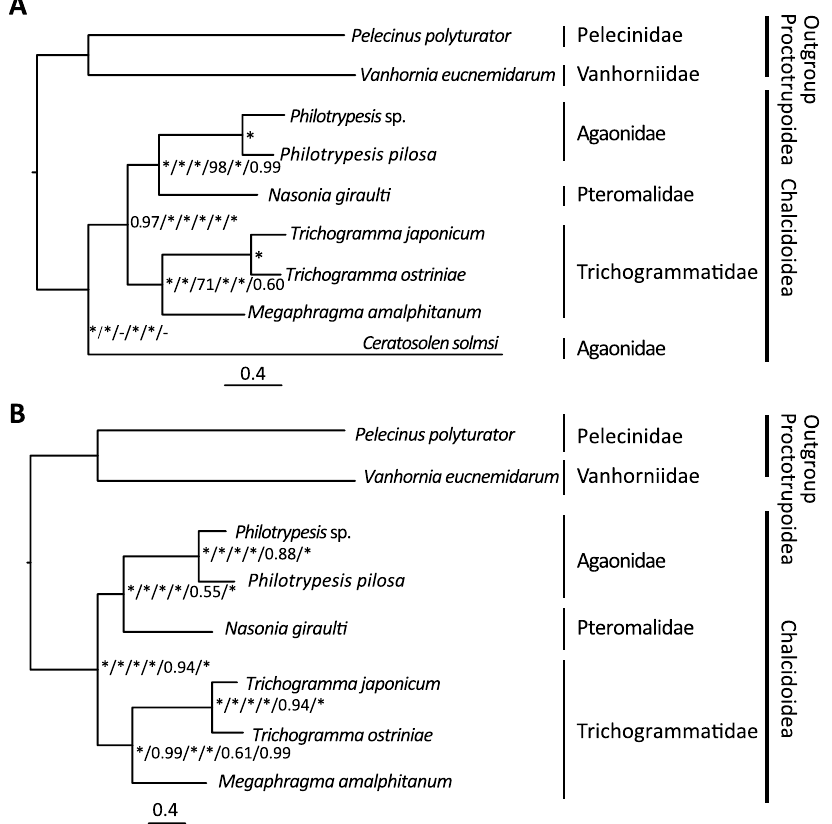
Figure 3. Phylogenetic relationships within Chalcidoidea based on the nucleotide and amino acids sequences of 13 protein-coding genes. ( A ) Seven species of Chalcidoidea with mitochondrial genome sequence were included. ( B ) Ceratosolen solmsi was excluded from analysis to avoid the potential long-branch attraction. The values separated by “/” near the nodes represent support rates of corresponding node. The six values indicate the posterior probabilities of Mrbayes analysis based on nucleotide and amino acids sequences, bootstrap probabilities of IQ-TREE analysis based on nucleotide and amino acids sequences, posterior probabilities of Phylobayes analysis based on nucleotide and amino acids sequences. “ * ” indicates the 1.0 Bayesian posterior probability and 100 bootstrap value and “ − ” indicates the absence of the node in corresponding